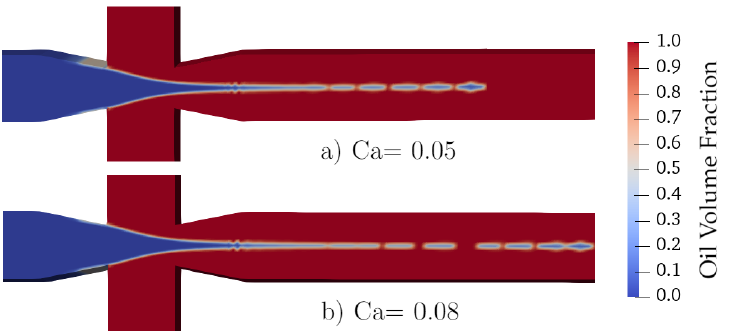
Figure 8. Transition from jetting toward tip streaming at high xanthan concentration for two Ca ; ( a ) Ca = 0.05, ( b ) Ca = 0.08.